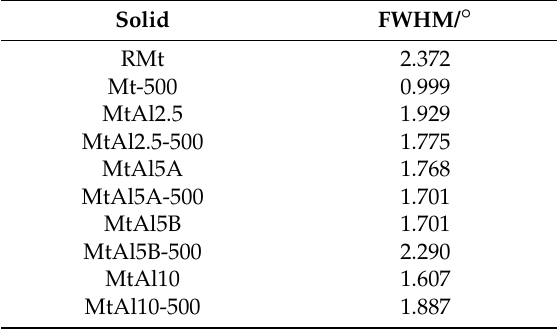
Table 5. Value of FWHM index of the